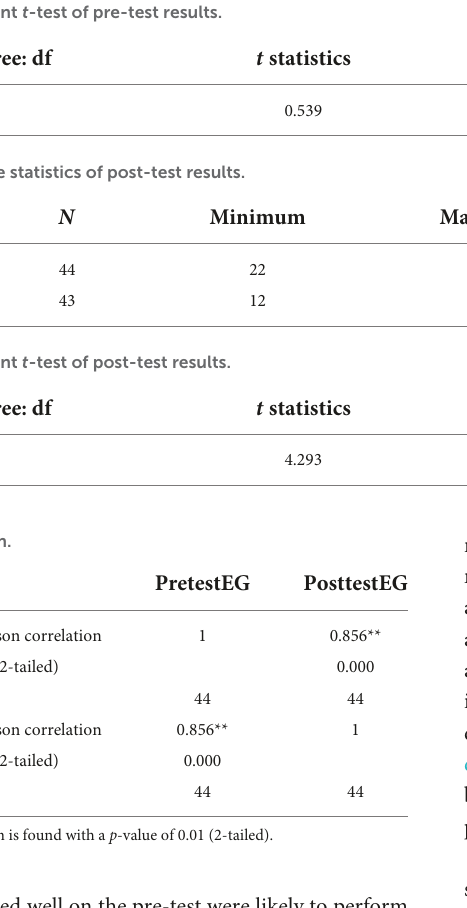
TABLE 3 Independent t -test of pre-test results.